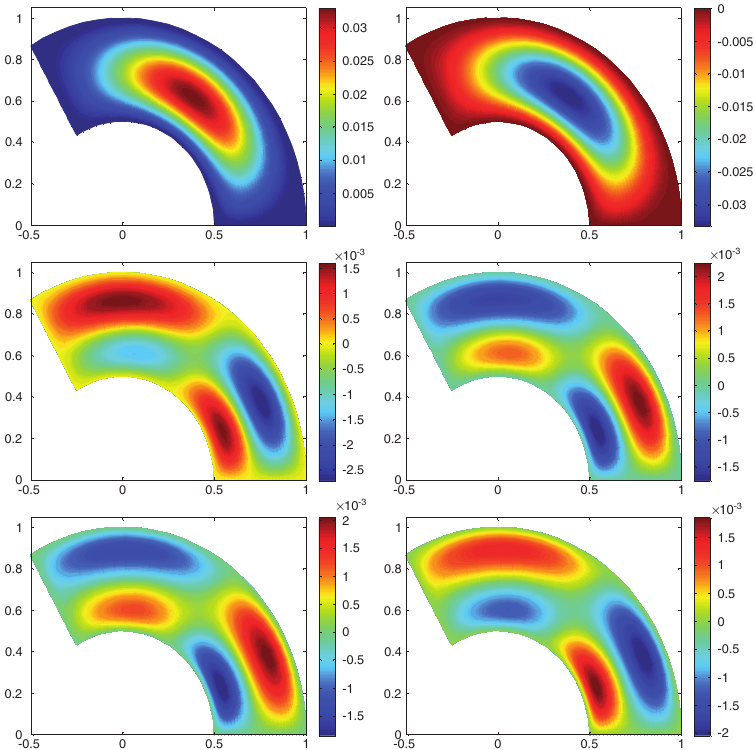
Figure 17 The first mode shapes of a fully clamped orthotropic FGM annular sector plate for different Winkler parameters: (A) 5e9, (B) 10e9, (C) 50e9, (D) 100e9, (E) 500e9 and (F) 1000e9 ( θ = 120 ° and n =